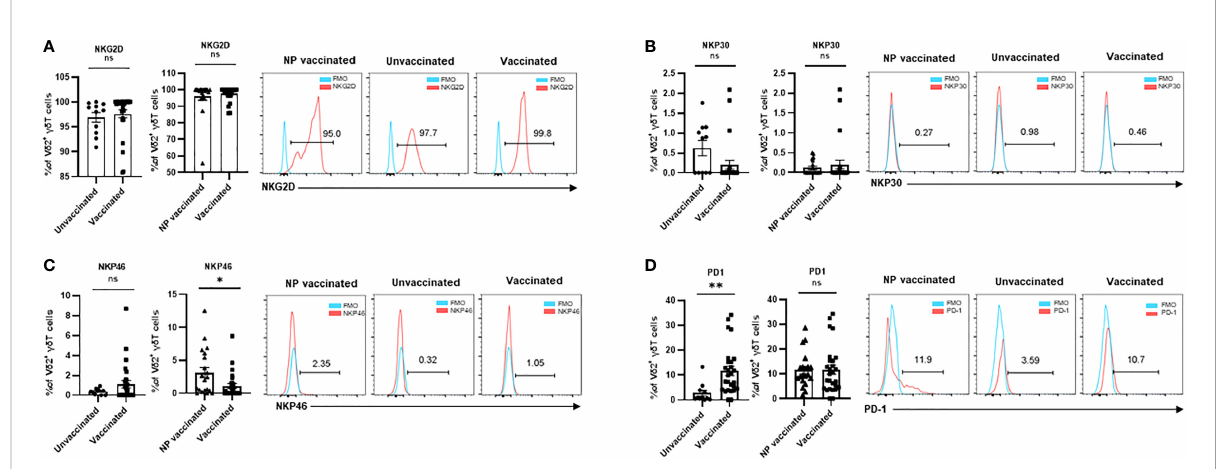
FIGURE 2 Expressions of crucial molecular of V d 2 + gd T cells in non-pregnant vaccinated women, vaccinated, and unvaccinated pregnant women. Comparable analysis of expressions of NKG2D (A) , NKP30 (B) ,NKP46 (C) and PD-1 (D) receptors of V d 2 + gd T cells acquired by fl ow cytometry. ns, no signi fi cance; *P < 0.05, **P <